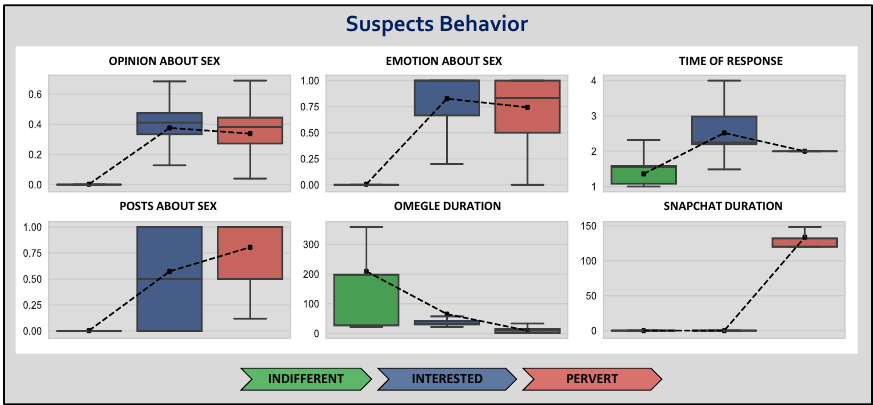
Figure 6. Behavior of profiled